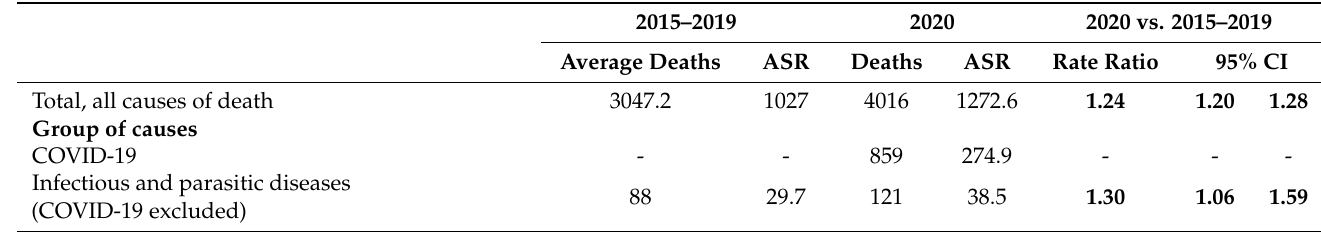
Table 1. Number of deaths and age-standardized 1 mortality rates (ASR) from all causes and groups of causes in men at all ages in 2015–2019 and 2020, the rate ratio and the corresponding 95% confidence interval (CI). Province of Pavia,